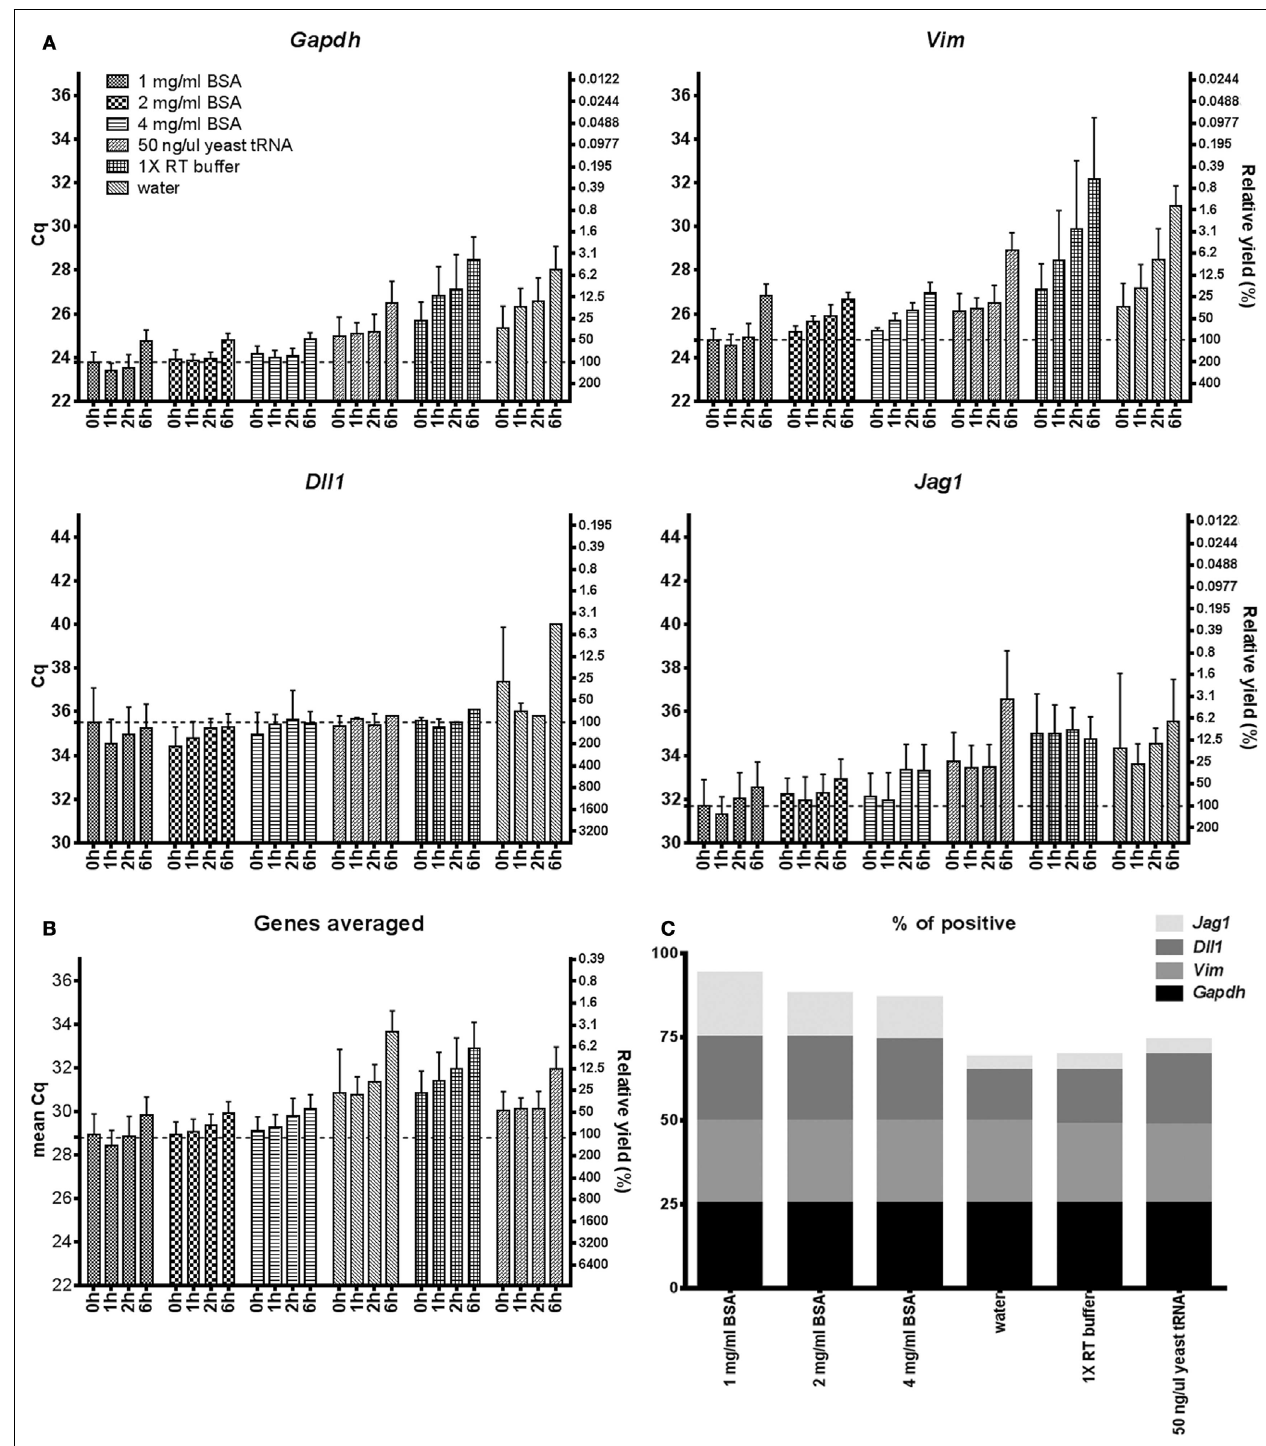
( n = 4). (B) Mean RNA accessibility of the transcripts. Expression of Gapdh , Vim , Dll , and Jag1 were averaged and compared to the 1mg/ml BSA condition at 0h. (C) Percentage of positive data points. Missing data were excluded from subplots (A,B) and are shown inTable S5 in Supplementary Material. Four genes and four time points were analyzed per lysis condition. GTC, guanidine thiocyanate; 1 × RT buffer, 1 × reverse transcription